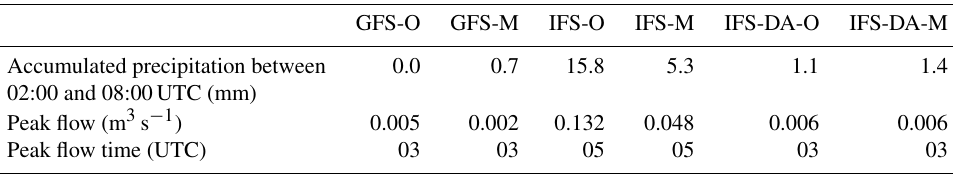
Figure 6. The 24h accumulated precipitation (mm) from 18:00UTC on 11 August 2015 to 18:00UTC on 12 August 2015: (a) merged ground measurements and radar observations simulated (b–g) using different configurations. The small blue (b–c) or white (d–g) stars highlight the accumulated rainfall peaks near Corigliano, which are analysed in detail in Fig. 7. Table 4. Accumulated rainfall between 02:00 and 08:00UTC, and simulated peak flow and peak flow time in the Citrea Creek for the different model